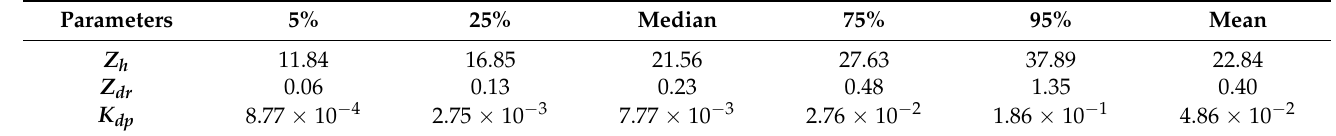
Table 3. The quantiles of variables for C-band polarization radar derived from DSD observations.